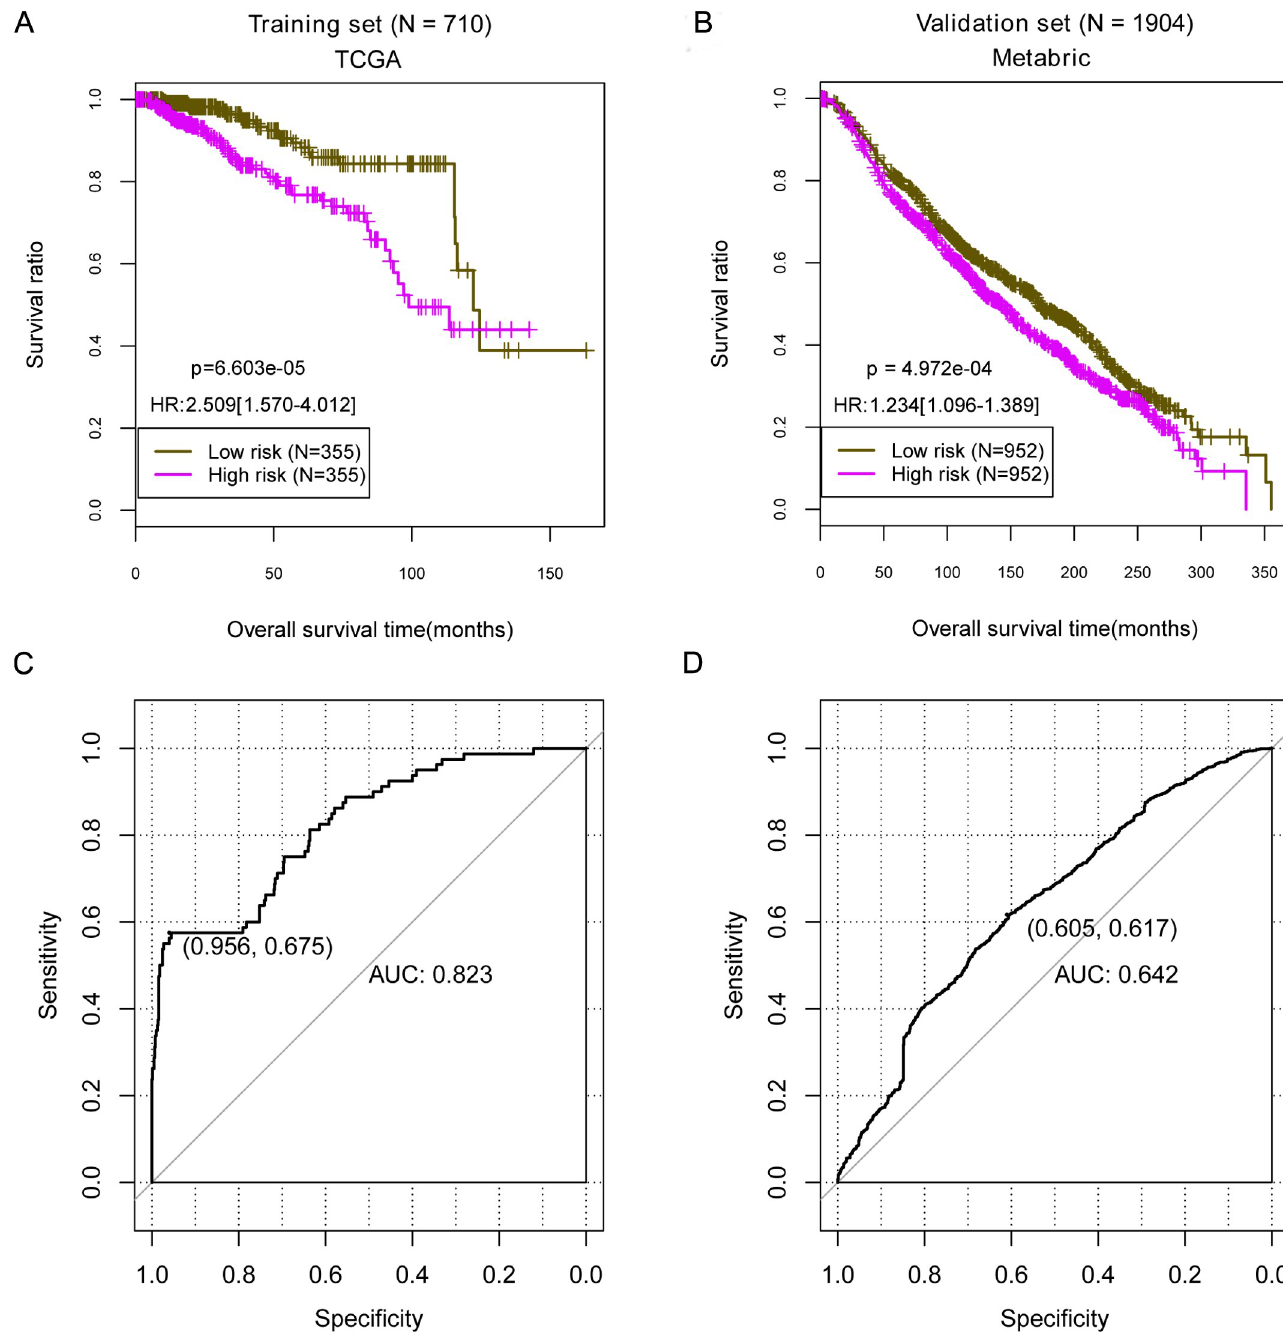
Fig 2. The mRNA prognostic model used the mortality risk score calculation in the TCGA training data set and METABRIC validation set. (A, B) showed the Kaplan-Meier curve based on the mRNA prognostic prediction model and the prognosis in the TCGA training data set and Metabric validation set. Significant differences were observed. (C, D) ROC curve of prediction result based on prognosis model. TCGA, The Cancer Genome Atlas. Metabric, Molecular Taxonomy of Breast Cancer International Consortium. ROC, receiver operating characteristic.